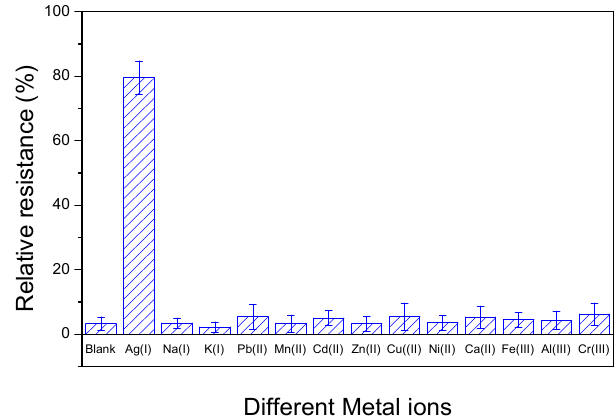
Figure 10. Relative resistance of the biosensor with 1 μM Ag(I) and 100 μM common metal ions. The error bars represent standard deviations based on three independent measurements.